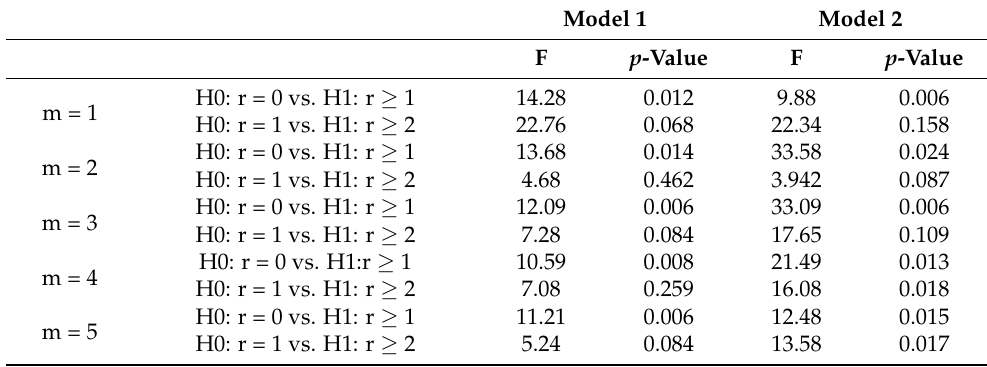
Table 7. Residual nonlinear